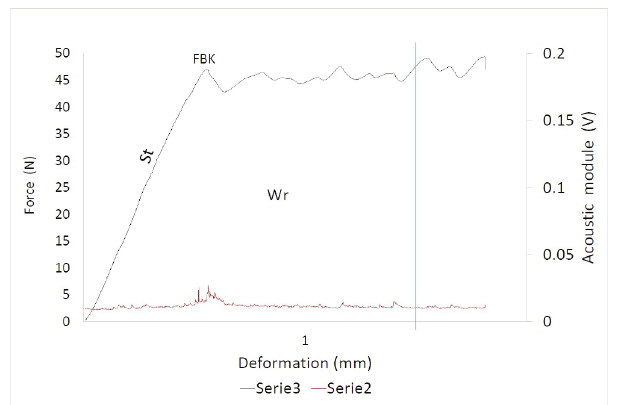
Fig. 2 ­ Force/deformation curve and acoustic profile of ‘Pomella Genovese’ apples. FBK= Force at the breaking point; Wr = Work; St=